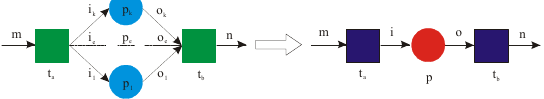
Fig.11. Parallel places reduction